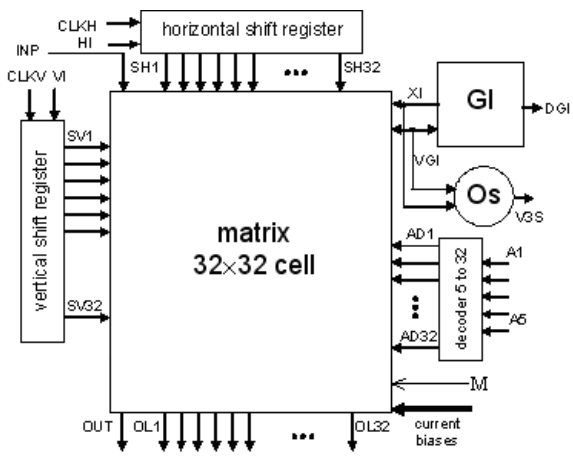
Figure 8. A block diagram of the SON processor.